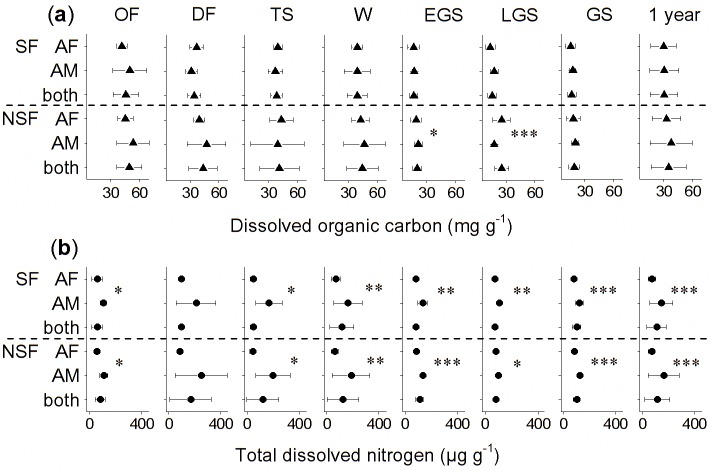
Means and 95% confidence intervals of the (a) dissolved organic carbon and (b) total dissolved nitrogen concentrations after each stage as well as in the winter, the growing season and for the entire year of decomposition in the alpine forest (AF) and the alpine meadow (AM) with the related litter combined, in the soil fauna (SF, above dashed line) and no soil fauna (NSF, below dashed line) treatments.* P<0.05, ** P<0.01 and *** P<0.001 tested by pairwise t-test.